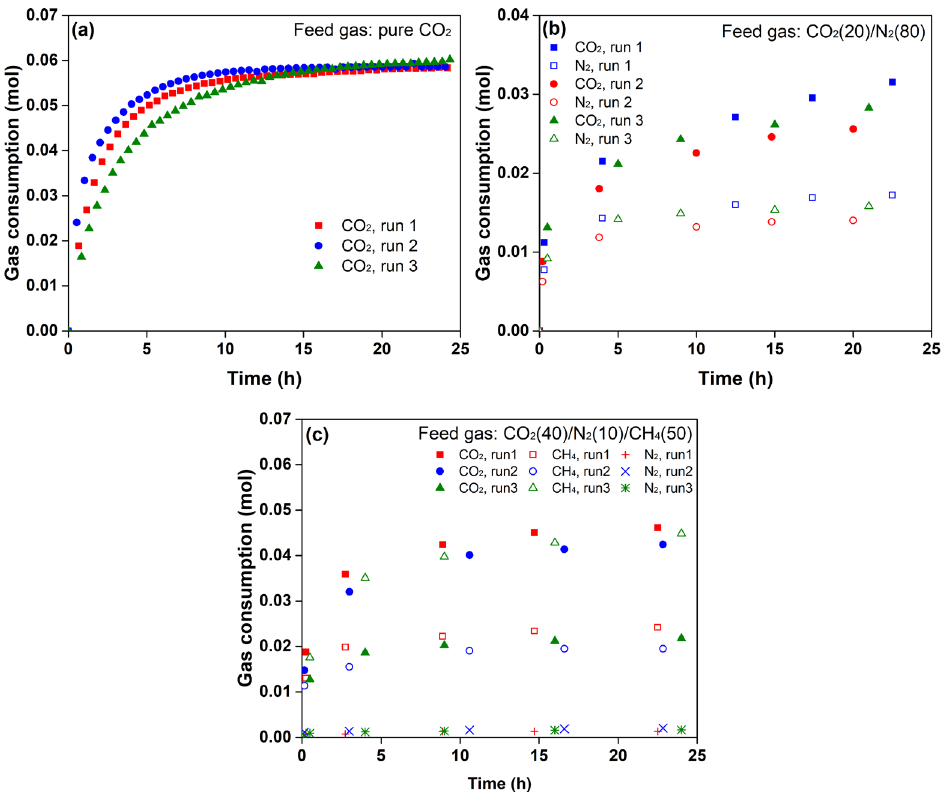
Figure 6. Profiles of the accumulated gas consumption in hydrate formation from ( a ) pure CO 2 , ( b ) flue gas, and ( c )